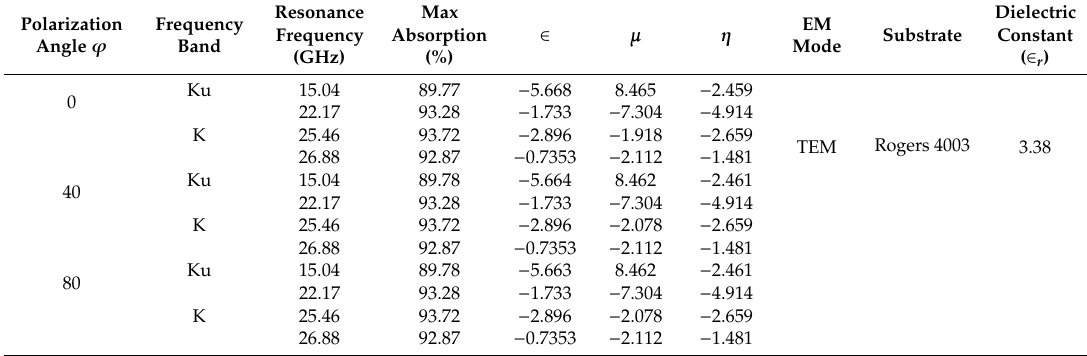
Table 5. Absorption at di ff erent polarizing angles in TEM mode for RT 4003